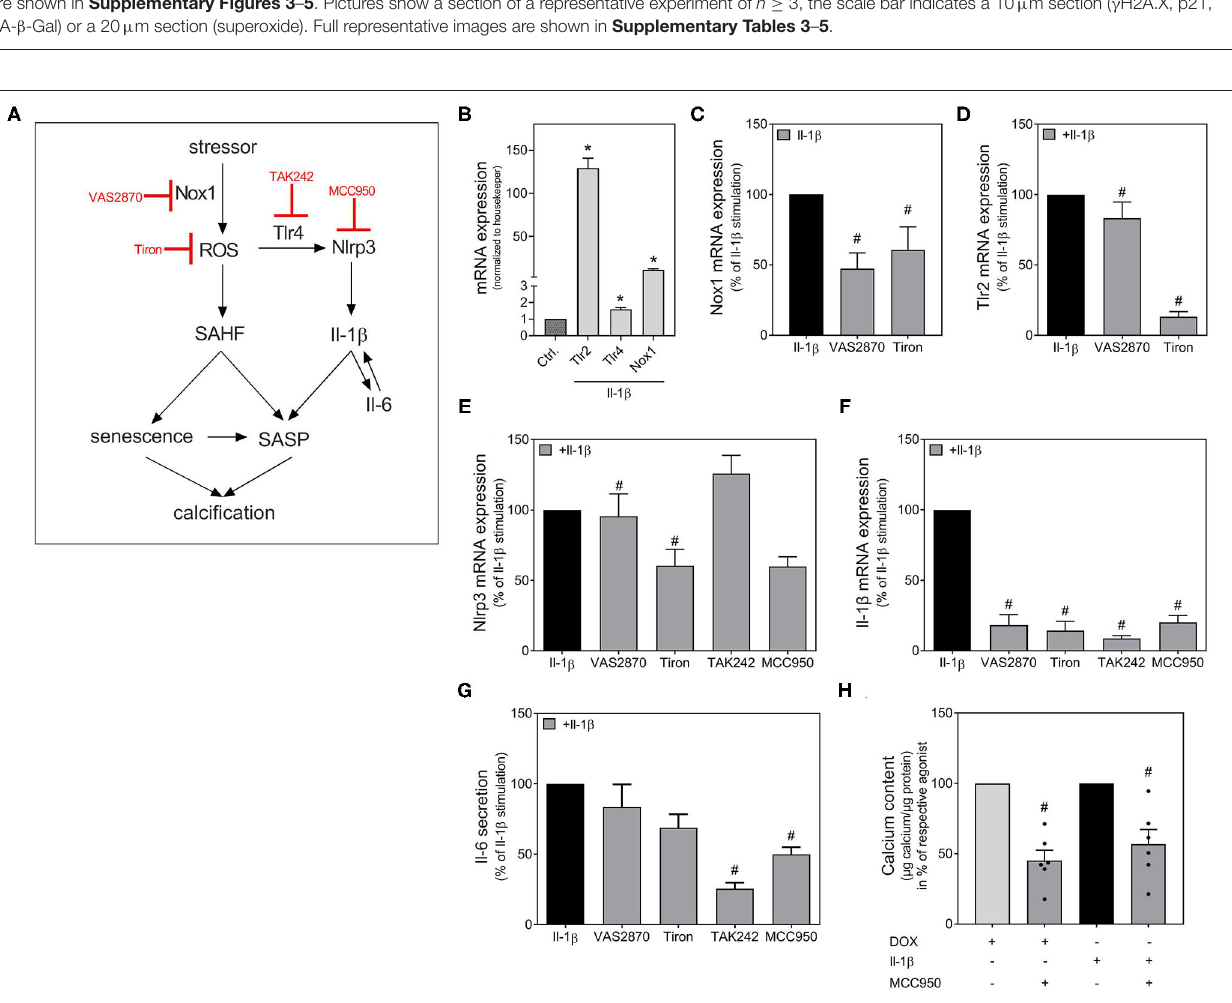
reflect the whole spectrum of senescence induction in VSMCs, DNA damage is a known and well-documented inducer of cellular senescence (9, 11). As shown recently by Shanahan’s group, the formation of nuclei positive for γ H2A.X and ATM in VSMCs is induced by calcium phosphate and correlates with the induction seen by other DNA damagers as DOX